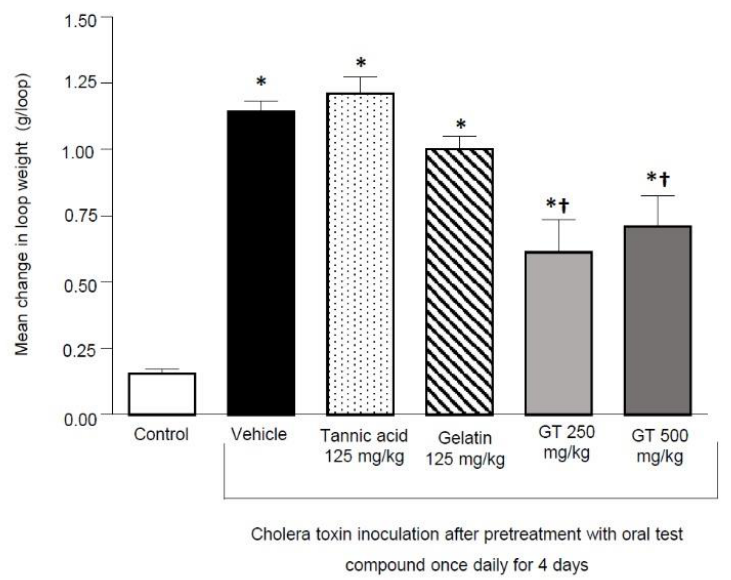
Figure 1. Four days’ oral pretreatment with gelatin tannate 250 mg/kg/day or 500 mg/kg/day prior to cholera toxin (CT) inoculation significantly attenuated mean CT-induced water secretion relative to vehicle in isolated jejunal loops of anesthetized rats ( n = 8/group). * p < 0.05 vs. control, † p < 0.05 vs. vehicle.